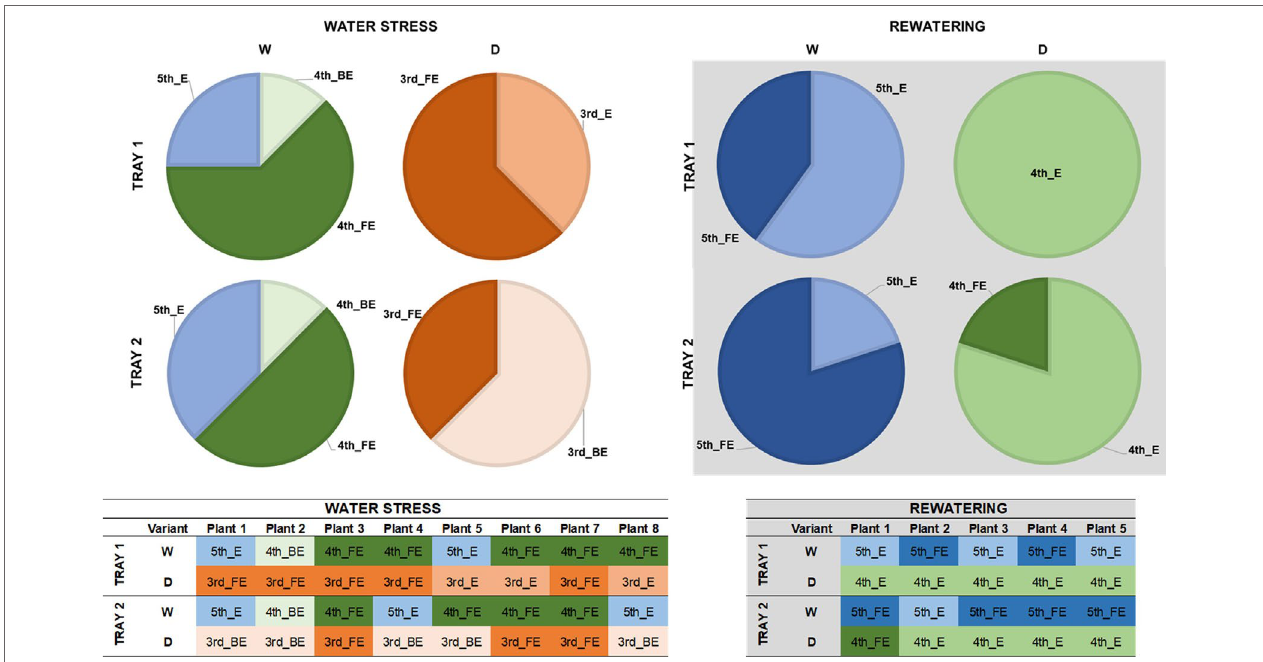
FIGURE 6 | Developmental stages of barley seedlings ( Hordeum vulgare ) under water stress and after subsequent rewatering. Developmental stages of leaves in stressed (D) and non-stressed (W) plants from two independent trays (1 or 2) at the end of the water stress period (n = 8) (Left panel) and after rewatering (n = 5) (Right